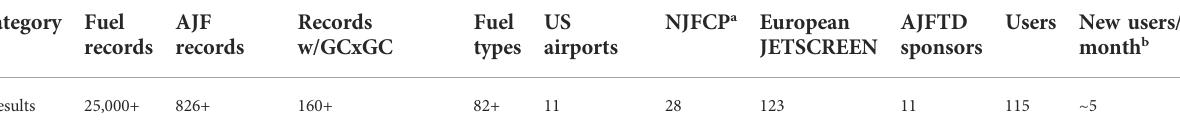
TABLE 1 Alternative jet fuel test database summary